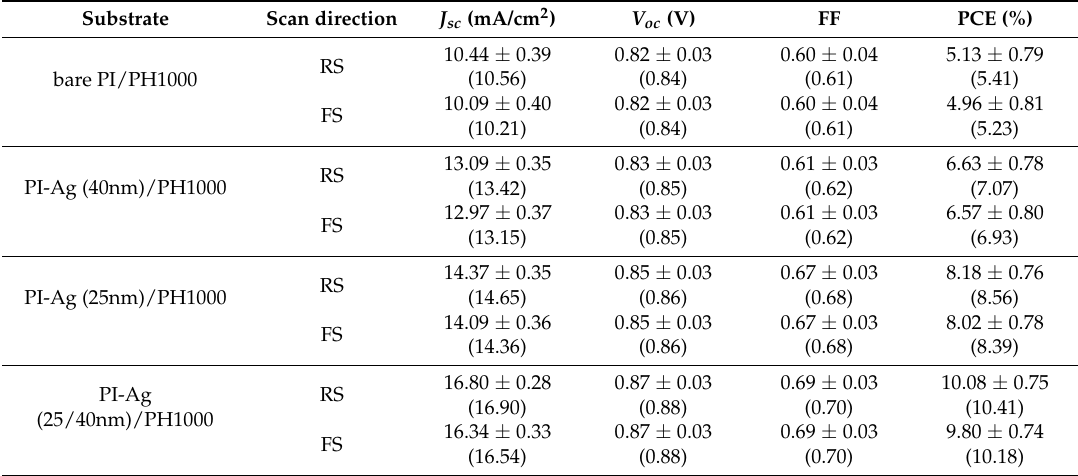
Table 1. Device parameters of perovskite devices based on different